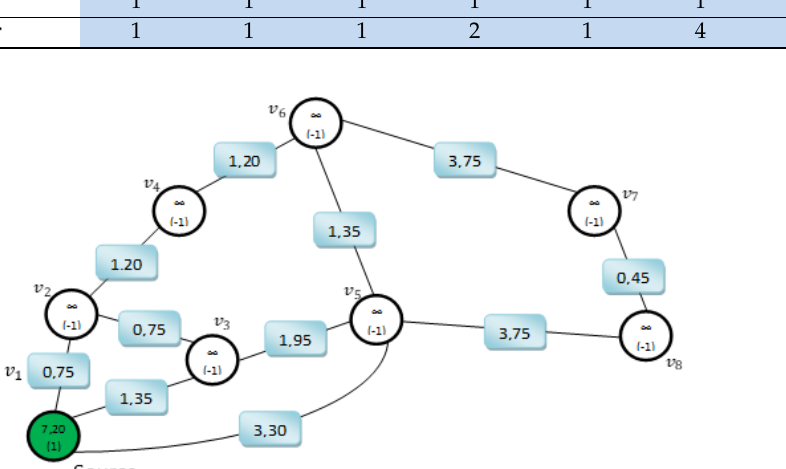
Figure 3. Finding the optimal path from peak 1—step 0.